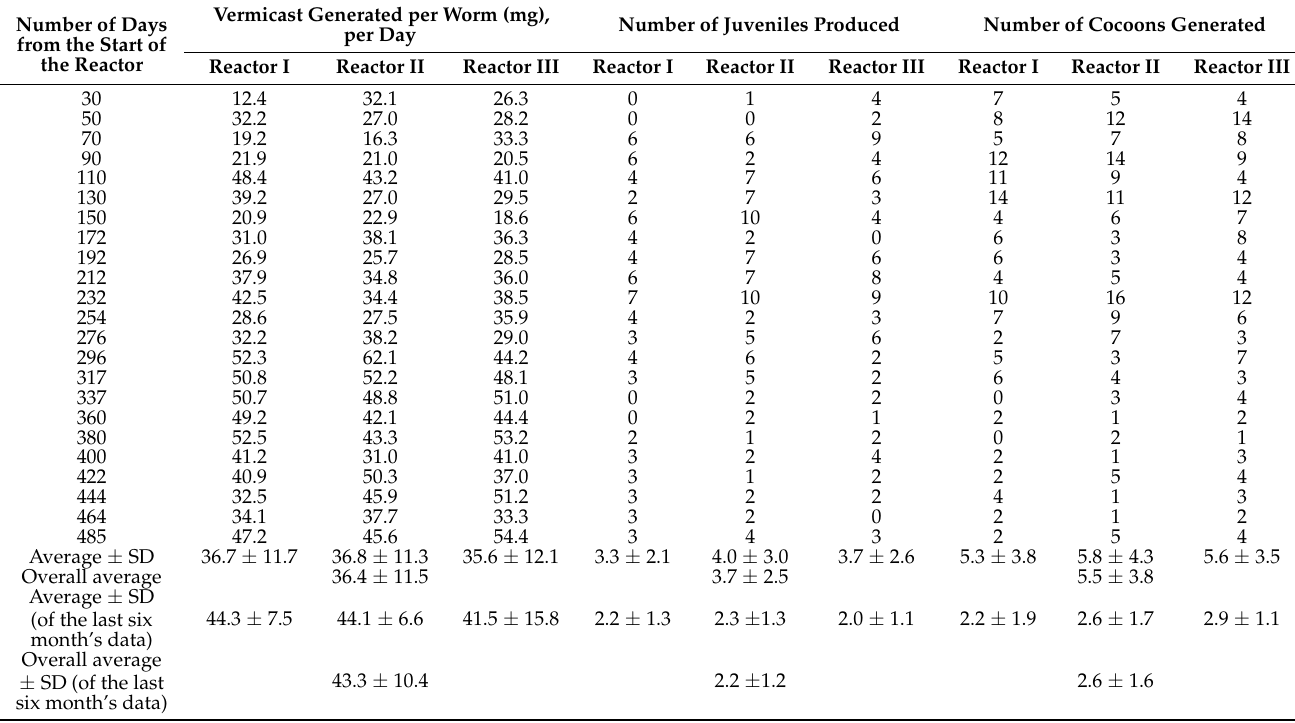
Table 2. Vermicomposting of lantana with 20 adults of E. fetida per kg of feed in pulse-fed modules.